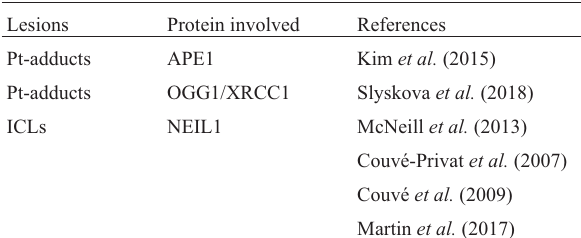
Table 3 - Bulky lesions recognized by